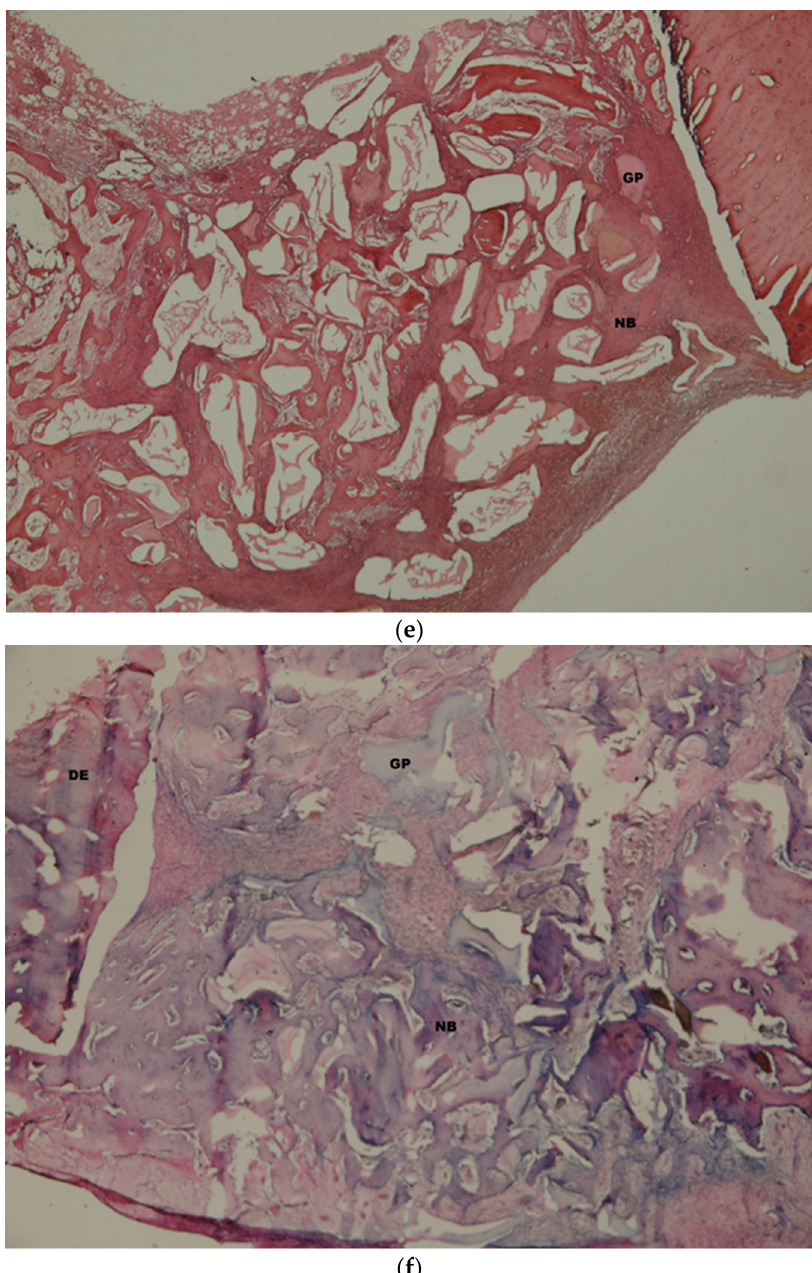
Figure 9. ( a ). Histological view of the empty defect group on the 6th week. Large new bone formation (NB) was determined near the defect edge (DE) H&E × 100. ( b ). Histological view of the autogenous group (group A) on the 6th week. new bone formation (NB) and graft particles (GP) between defect margins (DE). H&E × 100. ( c ). Histological view of the dentin group (group D) on the 6th week. New bone formation (NB) and graft particles (GF) alongside the defect edge (DE) H&E × 100. ( d ). Histological view of the xenograft group (group X) on the 6th week. New bone formation (NB) and graft particles (GF) near the defect edge (DE) H&E × 100. ( e ). Histological view of the autogenous + xenograft group (group A + X) on the 6th week. New bone formation (NB) starting from the defect edges (DE) and rest graft particles (GP) H&E × 100. ( f ). Histological view of the dentin + xenograft group (group D + X) on the 6th week, H&E × 100. The evaluation of the amount of residual graft in groups D, X, A + X and D + X (Table